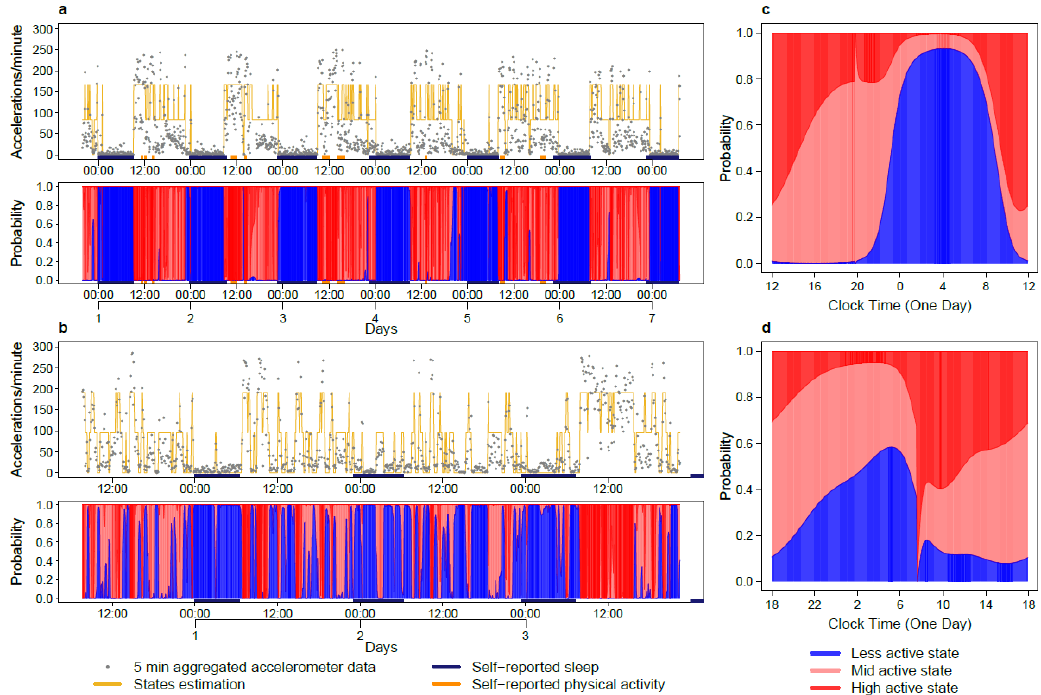
Figure 2. Rest-activity states estimation. ( a ) Rest-activity plots of one patient in the (I < O) high group, with an I < O value of 99.1%. Top row: time series of rest-activity with yellow line indicating the most likely state using hidden Markov modelling (HMM) decoding. Bottom row: state probability plot showing the cumulative probabilities of low (blue), intermediate (pink) and high (red) active states. The color bars represent the patient’s self-reported sleeping and physical exercise spans. ( b ) Rest-activity plots of an example patient in the (I < O) low group, with an I < O value of 86.5%. ( c ) Circadian state probability plot from harmonic HMM of the rest-activity pattern of the patient shown in (a). The panel shows the periodic time profile of the three state probabilities plotted as a cumulative manner analogous to the state probability plot with same color coding as in the bottom row of (a). ( d ) Circadian state probability plot from harmonic HMM of the rest-activity pattern of the patient shown in (b).